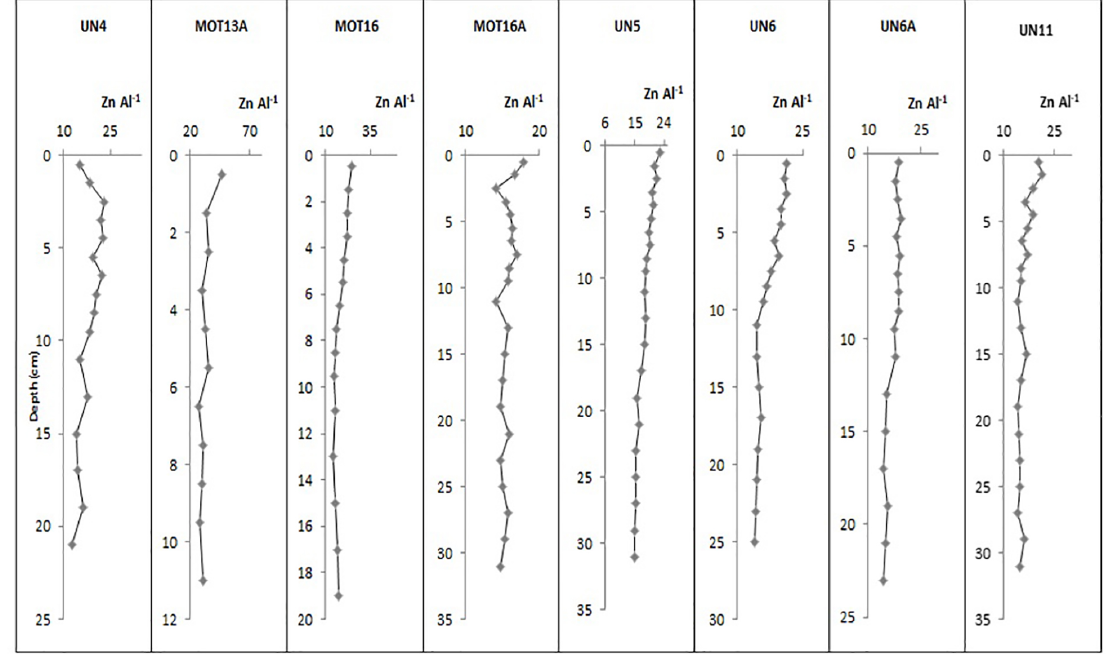
Figure A15. Vertical distributions of Zn Al − 1 × ( 10 4 ) in sediment cores. The ratios in thew coarse cores MOT13A, MOT16 and UN4 are calculated at the fine-sediment fraction ( <